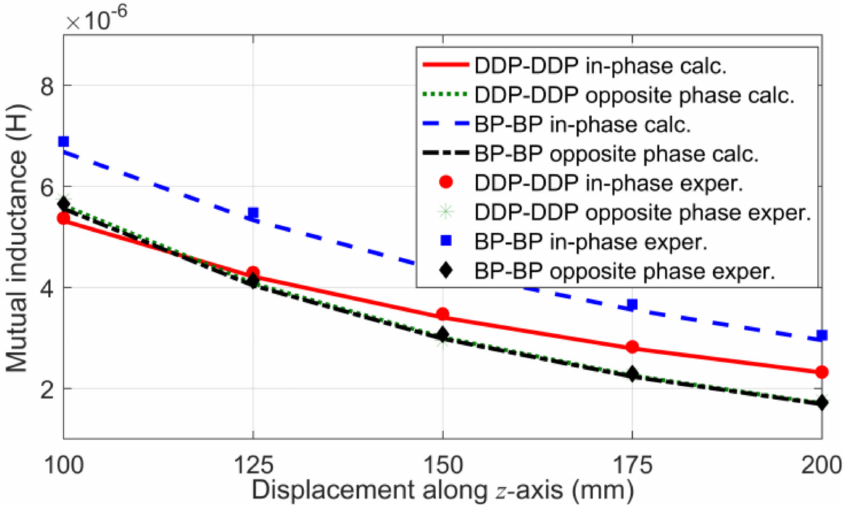
Figure 10. Experimental results and calculation results of mutual inductance for the two polarized couplers under misalignment along the z